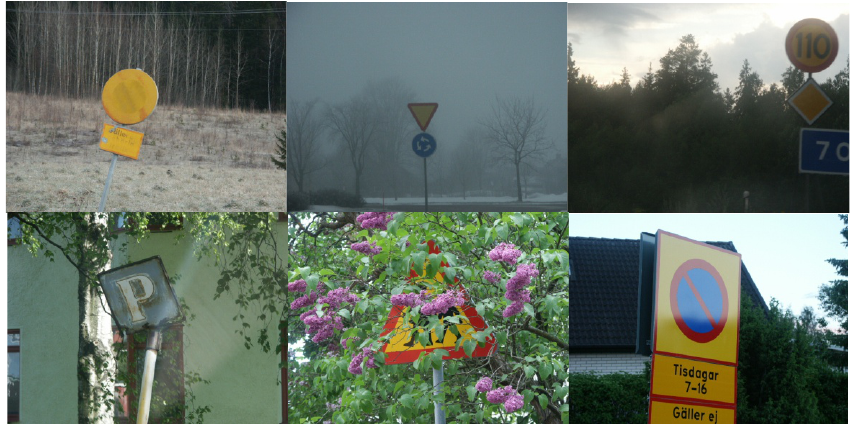
Figure 1. Potential difficulties when dealing with signs, from upper left to bot- tom right: Faded, Challenging weather conditions, Bad lighting geometry, Damaged sign, Occluded sign, and Highlighted